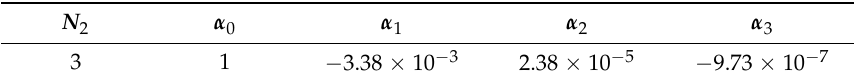
Table 1. Mean values of the polynomial parameters for f 2 ( θ